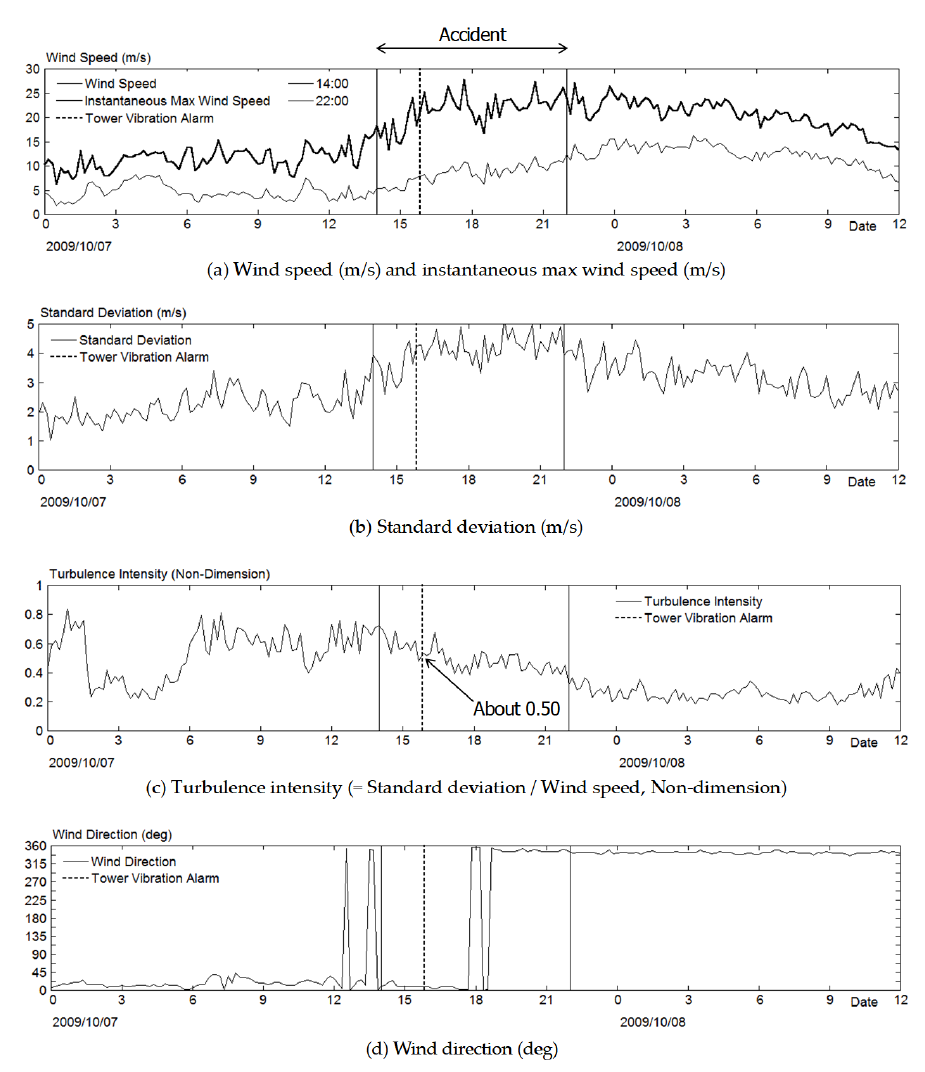
Figure 6. Time series of 10 min average data from the hub height (50.0 m) of Wind Turbine No. 17. Midnight, 7 October 2009 to noon, 8 October 2009.